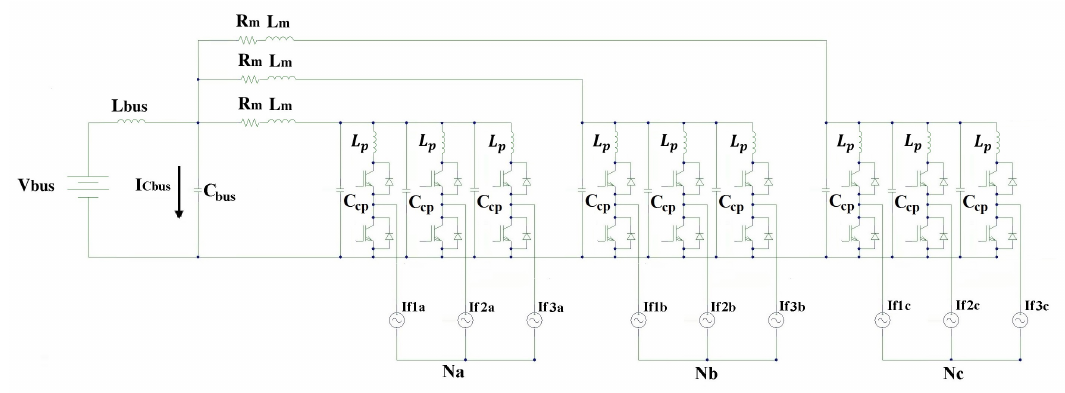
Figure 17. Triple-3-phase converter IGBT based including parassitic inductance Lpar , commutation path capacitors Ccp , DC-link connecting cable resistance Rm and inductance Lm .